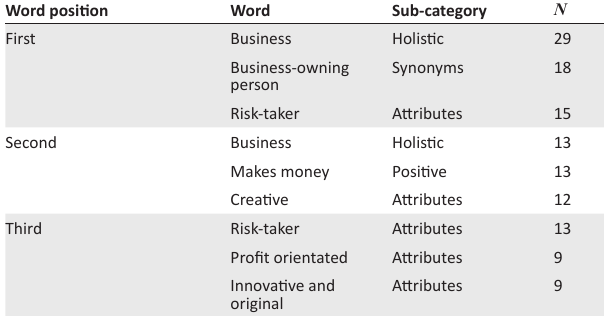
TABLE 3: Positioning of words.